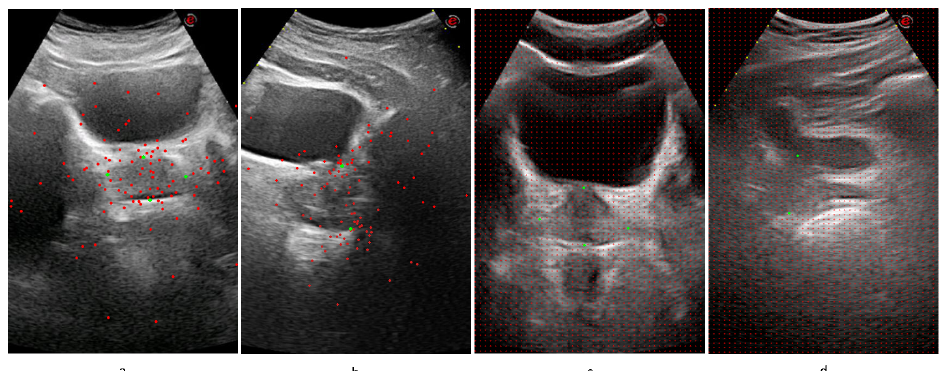
Figure 4. Patch centers are represented on AUS images. Expert marks are shown in green, while patch centers are shown in red. ( a ) Random sample training patch centers on a transverse image. ( b ) Random sample training patch centers on a sagittal image. ( c ) Sample test patch centers on a transverse image. ( d ) Sample test patch centers on a sagittal image.